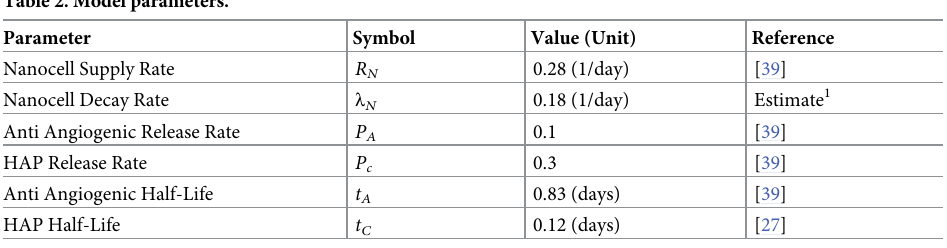
1 The nanocell decay rate is estimated by matching initial concentrations of combretastatin from the separate and nanocell